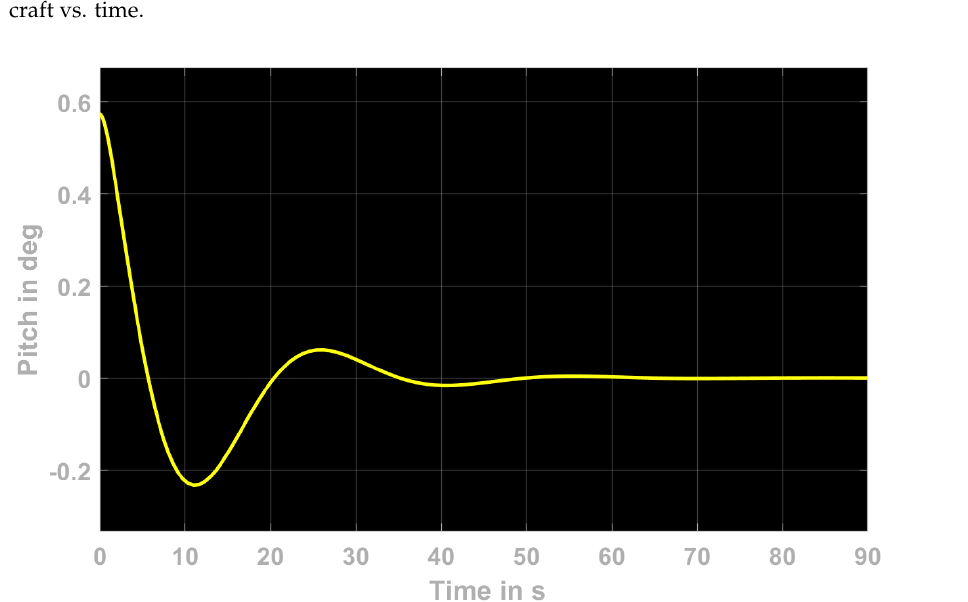
Figure 13. Dynamics in the vertical plane predicted by the LPM for the hybrid triangle design: pitch output of the craft vs.